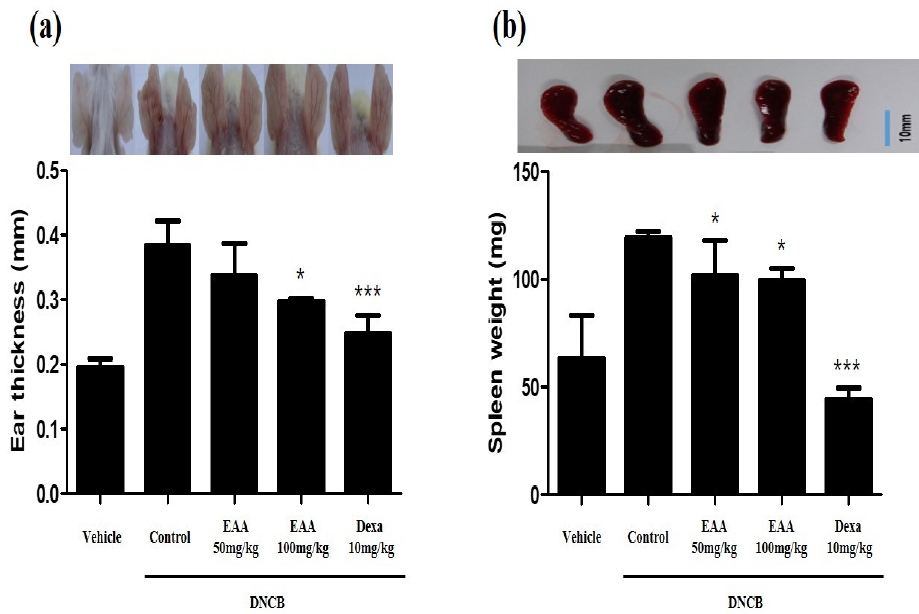
Figure 5. Effects of EAA on ear thickness and spleen hypertrophy. ( a ) Photographs of ear skin le- sions and measurements of ear thickness in DNCB-induced AD mice. Ear skin thickness measured with the help of a digital caliper. ( b ) Photographs of the spleen and spleen weight in DNCB-induced